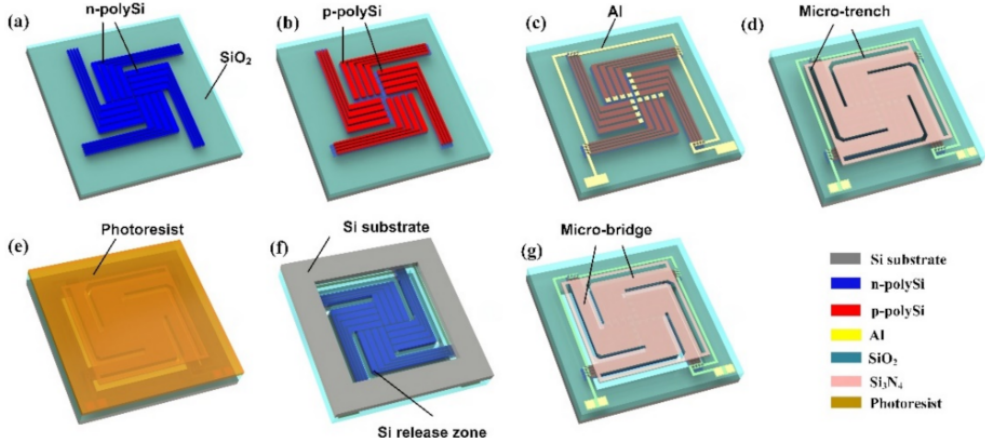
Figure 1. Schematic diagram of the process for fabricating an MB-based thermopile device. ( a ) Depo- sition polysilicon, implantation (P ion) and pattering, ( b ) Deposition oxide and polysilicon, implanta- tion (B ion) and patterning, ( c ) Metal Al sputtering and patterning, ( d ) Formation of micro-trench, ( e ) Spinning photoresist for protection, ( f ) Deep silicon releasing at the back-side, ( g ) Removing photoresist at the